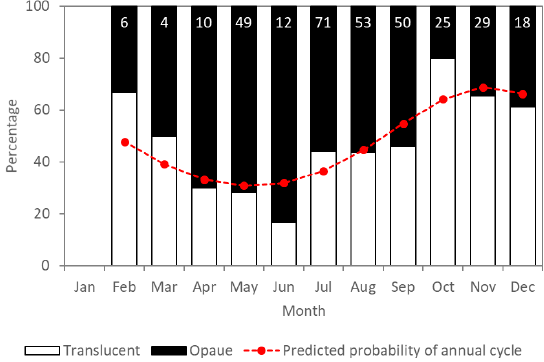
Figure 4. Monthly frequency changes in band edge on vertebral centrum for the spot-tail shark. Numbers indicate sample size, ● : predicted probability of annual cycle from Okamura and Semba’s method (2009).